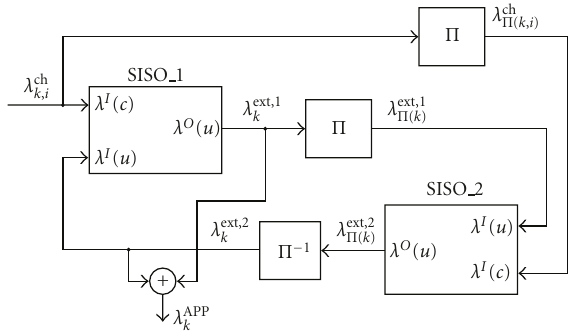
Figure 7: Decoding of PCCC codes: the turbo